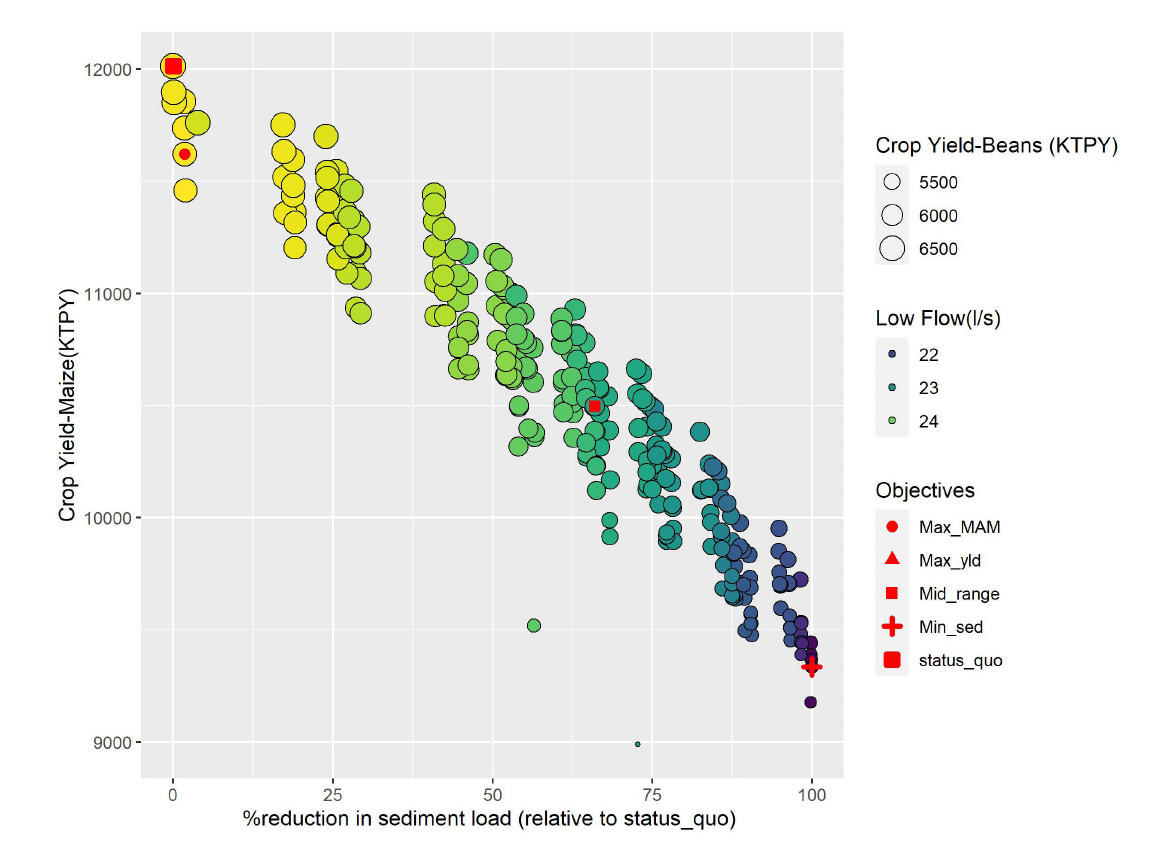
FIGURE3 Performance of the pareto solutions of scenario 1 for MAM, sediment load and crop yield objective